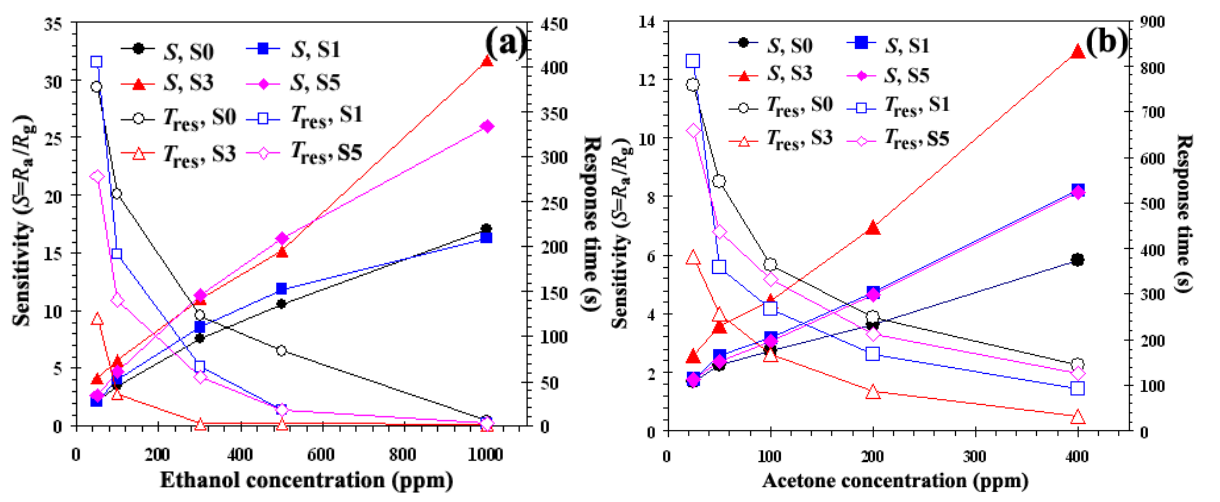
Figure 5. Sensitivity of S0, S1, S3, and S5 (filled symbols, left axis) and the corresponding response time (open symbols, right axis) of (a) ethanol and (b) acetone